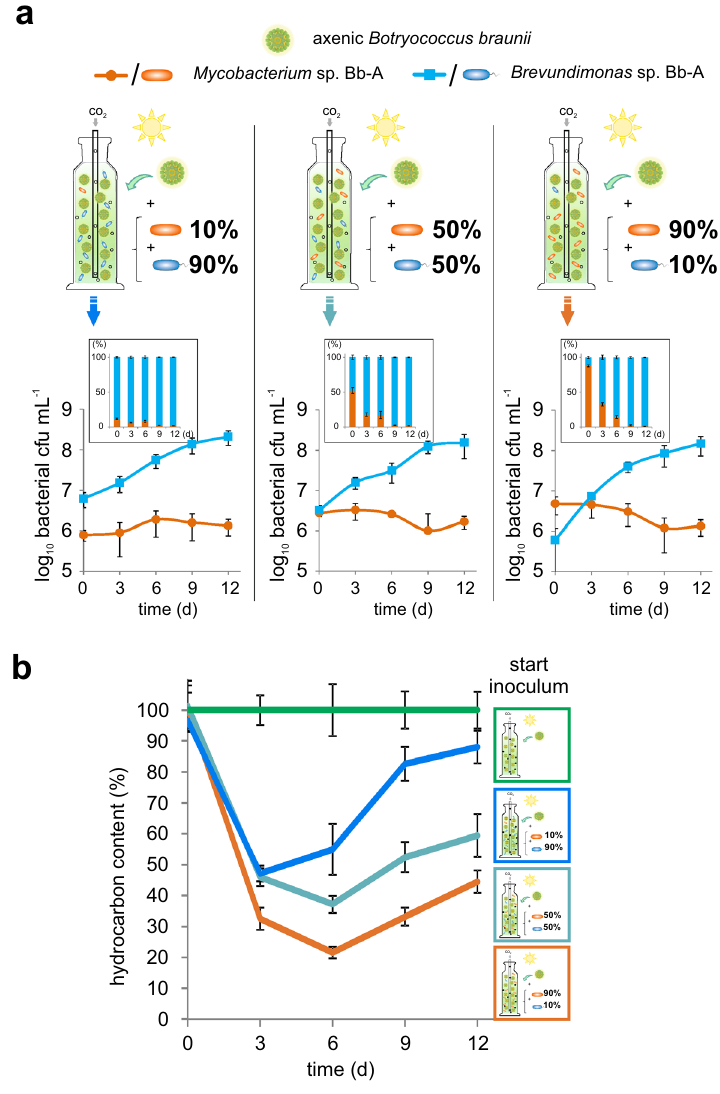
Figure 4. Bacterial symbionts fend their eukaryotic host from hydrocarbonoclastic invaders. Physiology of a synthetic alga-bacteria-bacteria community, consisting of Brevundimonas sp. Bb-A (blue) and Mycobacterium sp. Bb-A (orange) in co-culture with B. braunii (green) under photoautrophic conditions with three different inoculum ratios (10:90, 50:50 or 90:10 per cent based on cfu (colony-forming units)). Shown are ( a ) the progression of bacterial proliferation ( cfu ) and ( b ) detected relative hydrocarbon levels (normalized to the axenic control) during the co-cultivation. The error bars represent standard error of mean values of three biological and three technical replicates (SE; n =